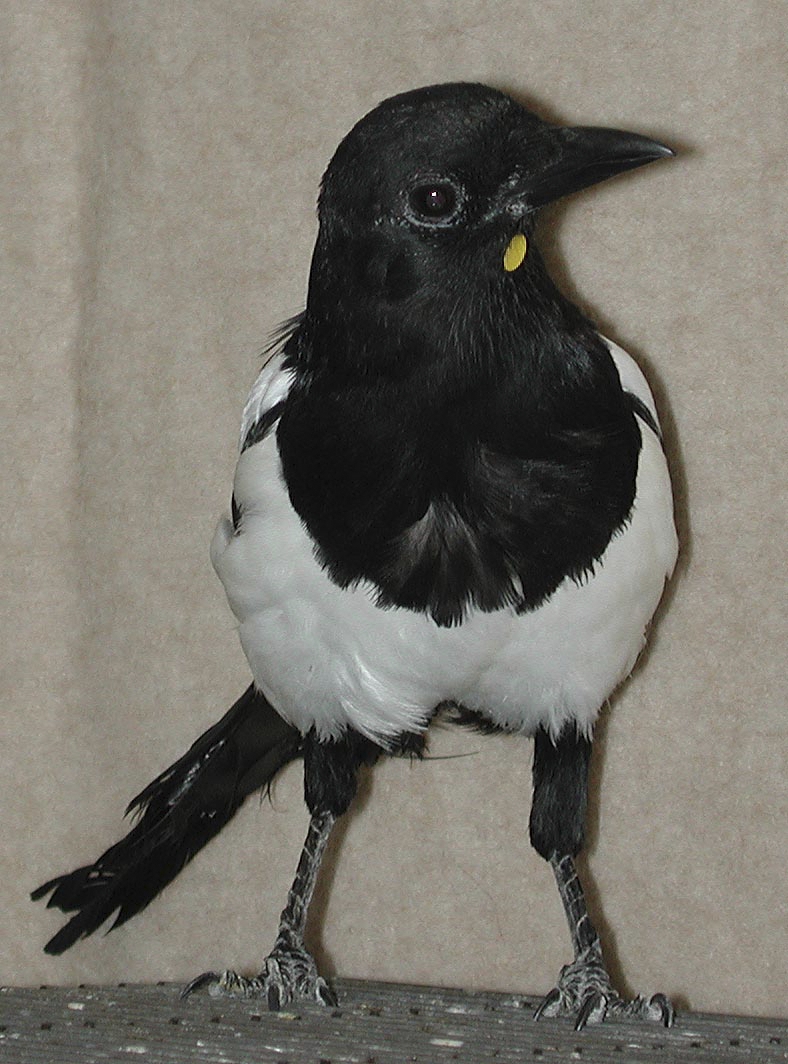
Magpie with Yellow Mark